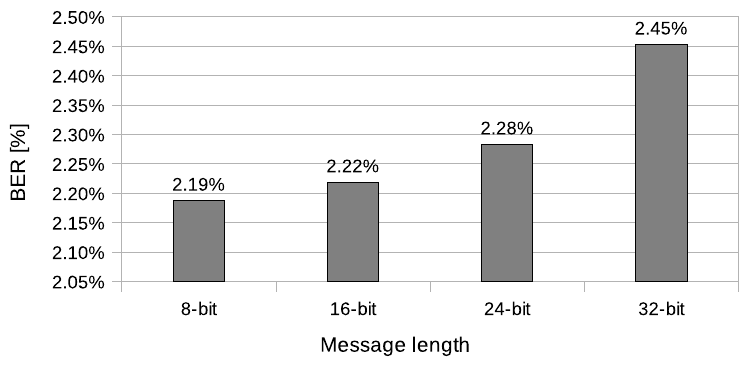
Figure 10. Measurement of the bit error rate (IEEE 802.11n; Both-informed).